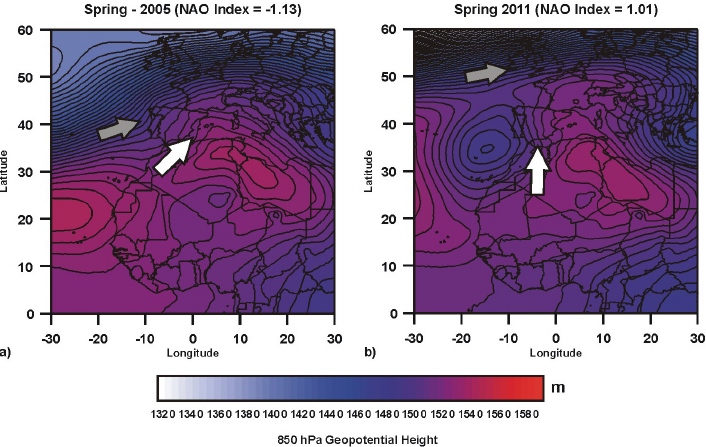
Figure 8. Composite 850hPa geopotential height (m) during episodic days in spring 2005 (a) and 2011 (b) . Grey and white arrows indicate Atlantic and African air mass flows,